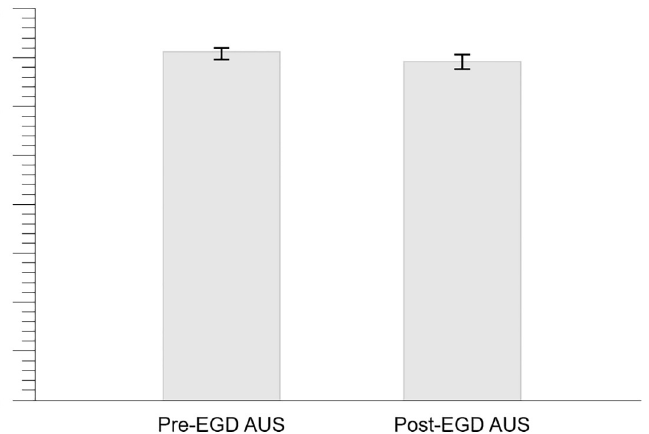
Fig 1. Means and 95% CIs for total image quality score. The means and 95% CI for the total image quality score for all 16 organs for pre- and post-EGD AUS are 3.54 [3.48–3.60] and 3.46 [3.39–3.52],